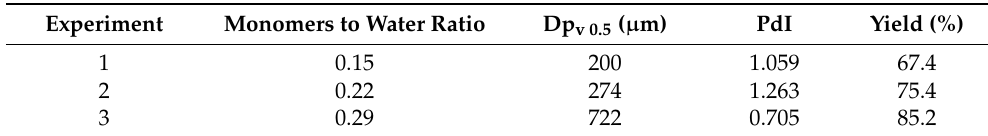
Figure 4. SEM micrographs of particles synthesized by suspension polymerization using different monomers to water ratios: 0.15 ( a ), 0.22 ( b ) and 0.29 ( c ). SEM micrographs show that the concentration of monomers and initiator does not affect significantly the shape of the particles, hence spherical and smooth particles in the micron size range for all experiments were obtained. However, the particle size seems to be affected by the particular monomer to water mass ratio, increasing with the monomer concentration. This influence was confirmed by the LALLS measurements. The median diameters in volume (Dpv 0.5) and polydispersity indexes (PdI) are shown in Table 3, which also includes the reaction yield. Table 3. Influence of monomers to water ratios in the polymerization yields and in the sizes and PdIs of St-MMA